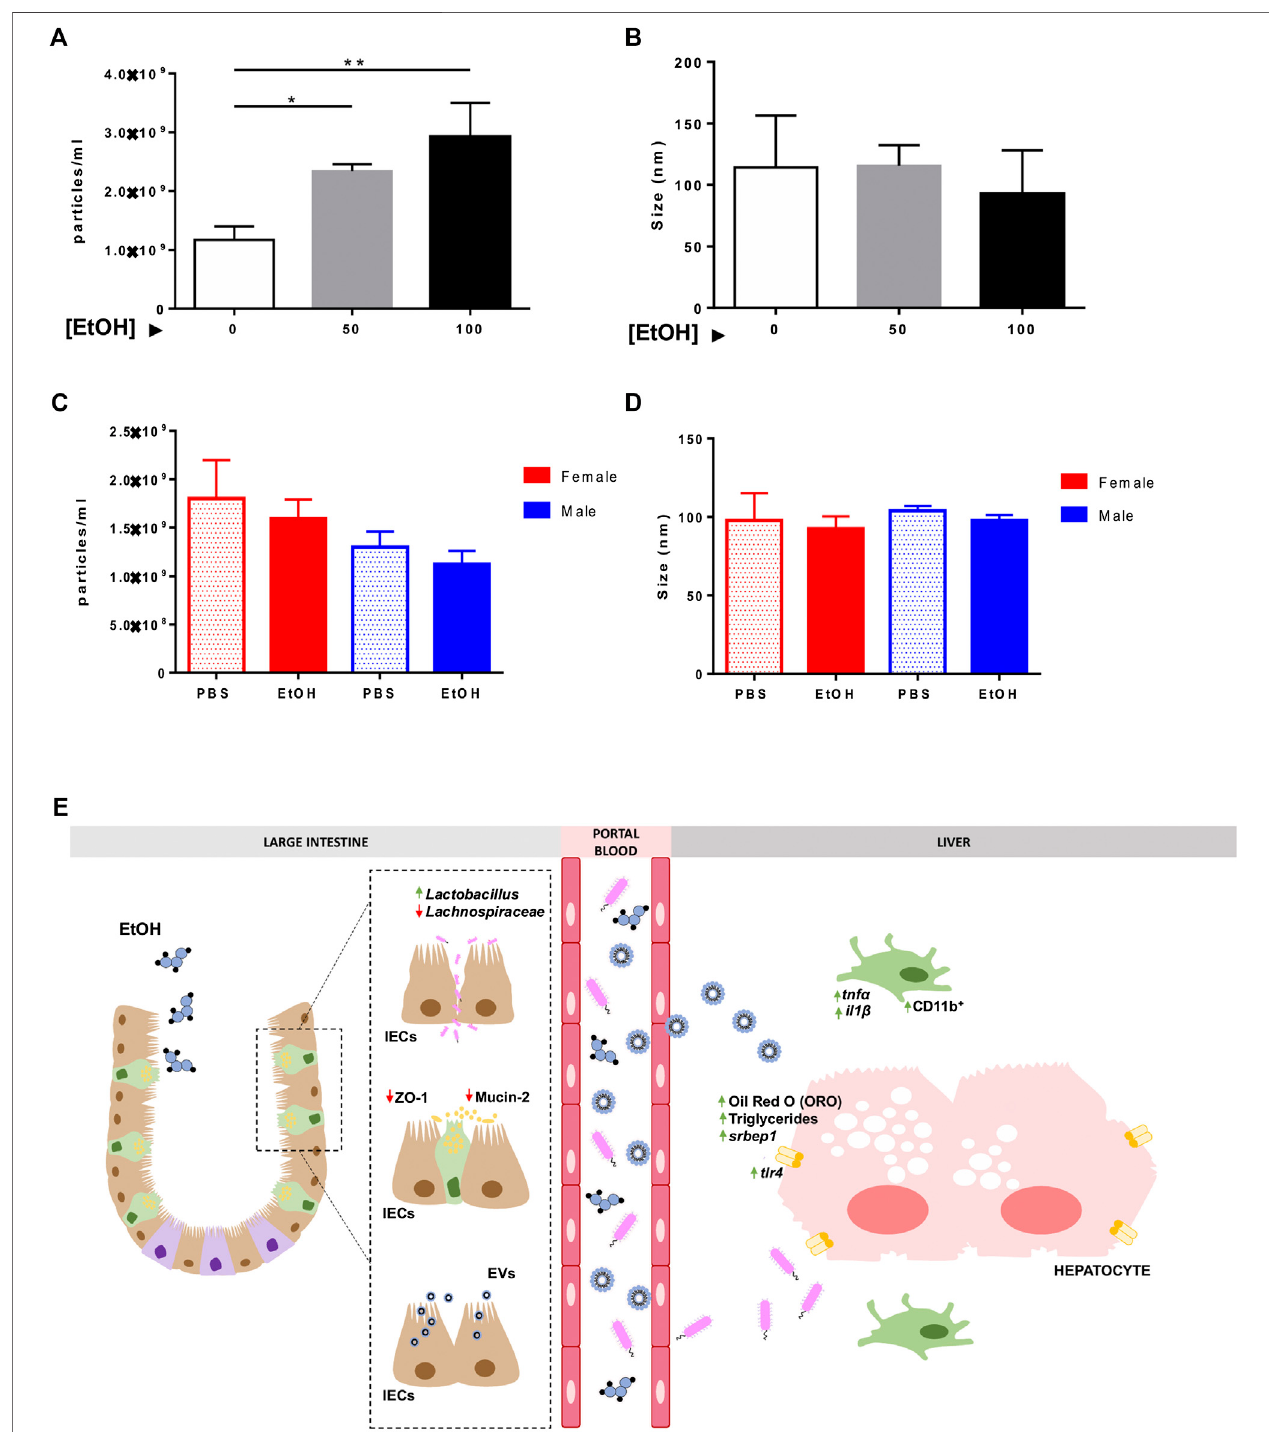
FIGURE6| Characterizationofextracellularvesicles invitro and invivo .IsolatedEVsfromthesupernatantofCaco-2cellschallengedwithdifferentconcentrationsofEtOH [0 – 100 mM]weremeasuredbyNTA,and (A) particles/mland (B) sizeofEVswererepresented.IsolatedEVswereextractedfromtheserumoffemaleandmalemicetreatedwith EtOH or PBS, and they were analyzed using NTA. (C) Particles/ml and (D) size of EVs were graphed ( n (cid:1) 3/group; * p < 0.05, ** p < 0.01). (E) Schematic representation of the pathophysiological events that occur during acute alcohol exposure. Acute alcohol ingestion triggers damage to the intestinal epithelial barrier. Increased FITC-Dextran, disruptionintightjunctions(ZO-1),andlossofmucosa(MUCIN-2)andalterationofthegutmicrobiota(increased Lactobacillus anddecreasedLachnospiraceae)indicatedamage to the intestinal epithelial barrier and gut dysbiosis. Translocation of microbial bacterial products through the leaky gut causes overexpression of tlr4 and intestinal-derived in fl ammation in the liver – presence of CD11b-positive cells, tnf- α , and il1 β , and mild steatosis and lipid accumulation. Our in vitro experiments suggest that ethanol triggers the release of EVs by intestinal epithelial cells (IECs), which exert a deleterious effect on hepatocyte viability and lipid accumulation.